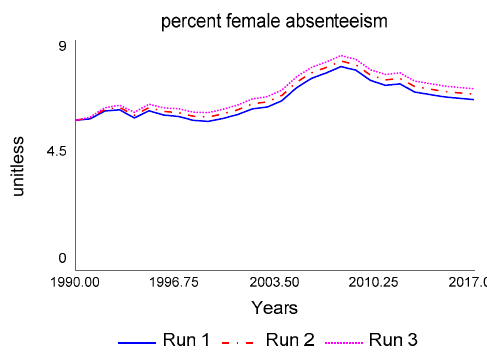
Figure A3. Sensitivity analysis of the non-linear graphical function shown in Figure A2. Run 1 is a decrease of 25% of the decision-making effect variable, Run 2 is the same behavior shown in the reference mode in Figure 1, and Run 3 is an increase of 25% of the effect.